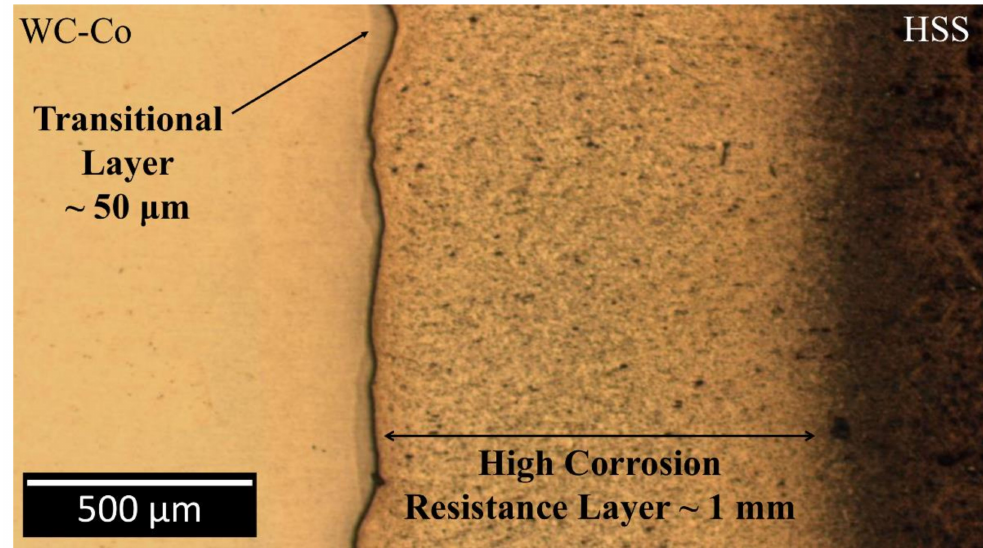
Figure 9. Optical image of the weld interface after chemo-mechanical polishing and chemical etching (Murakami 20 s and Nital 60 s). Evidence of an improved corrosion resistance layer of about 1 mm in thickness.